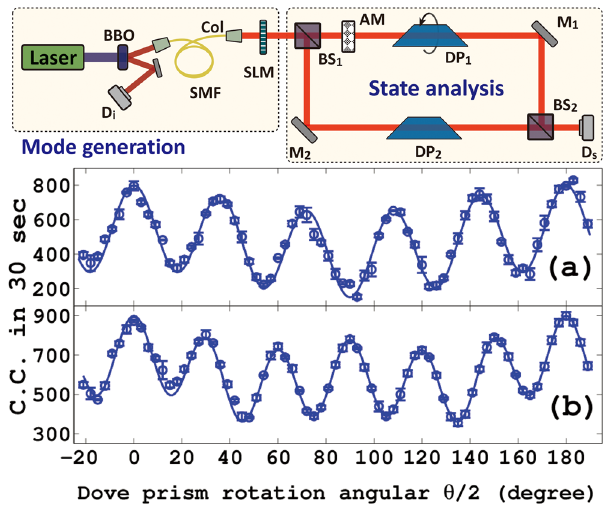
Figure 2. Experimental setup and results for multimode NOON states. SMF: single mode fiber; Col: collimator; SLM: spatial light modulator; AM: absorbing material; BS 1,2 : beam splitter; DP 1,2 : Dove prism; M 1,2 : mirror; D i,s : detector. ( a ) and ( b ) show the results for = + . L l l 2 5 , respectively. The round dots 1 2 6 and solid lines represent the experimental results and theoretical fitting,